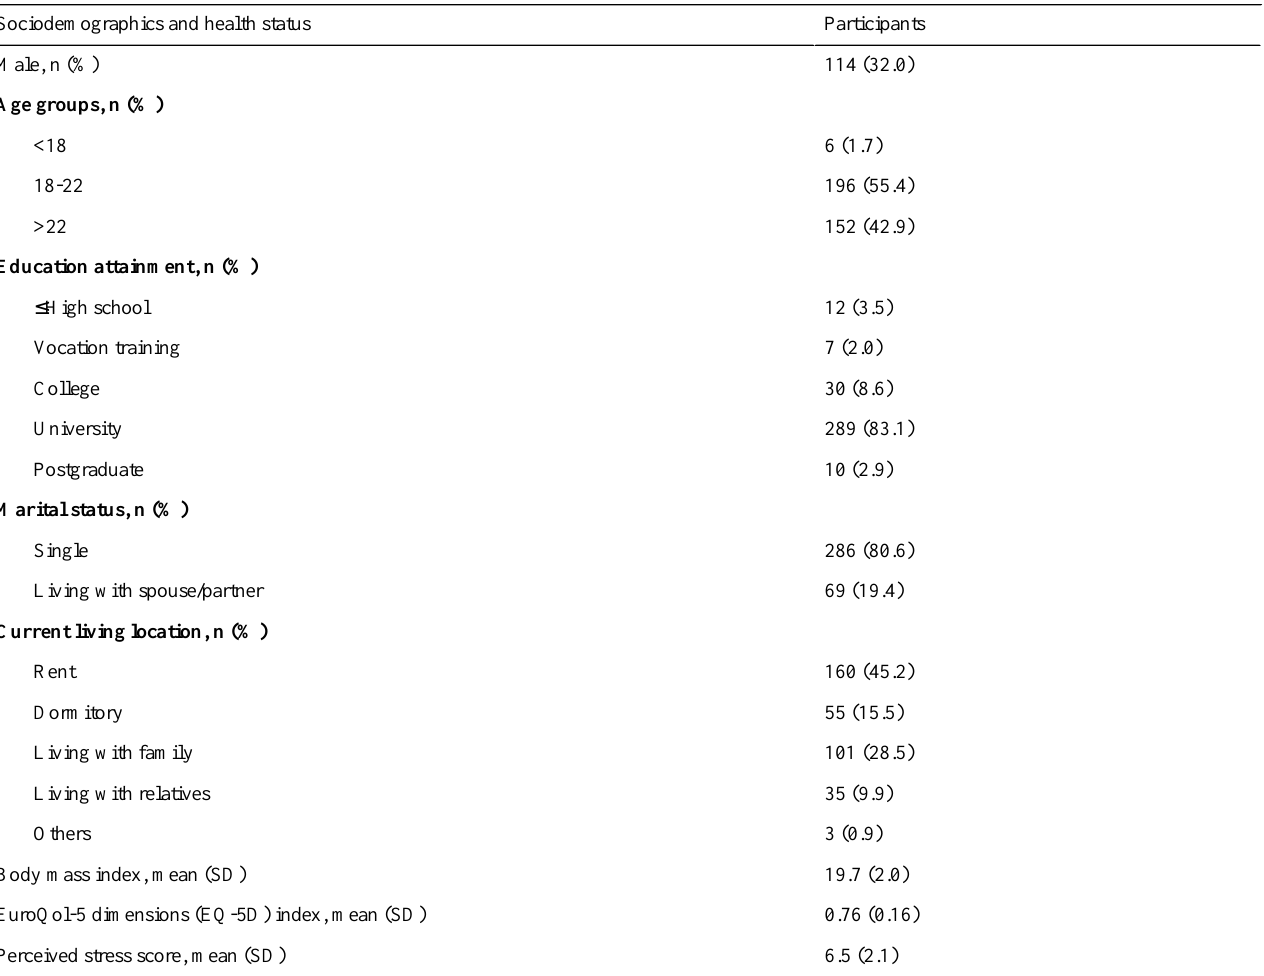
Table 1. Sociodemographics and health status of respondents